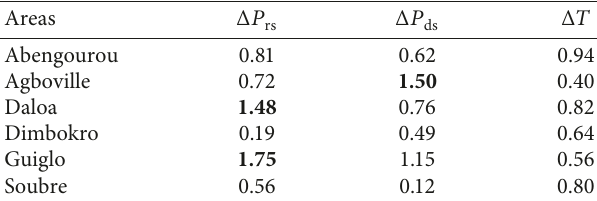
Table 3: Statistic results of the Student’s t -test.